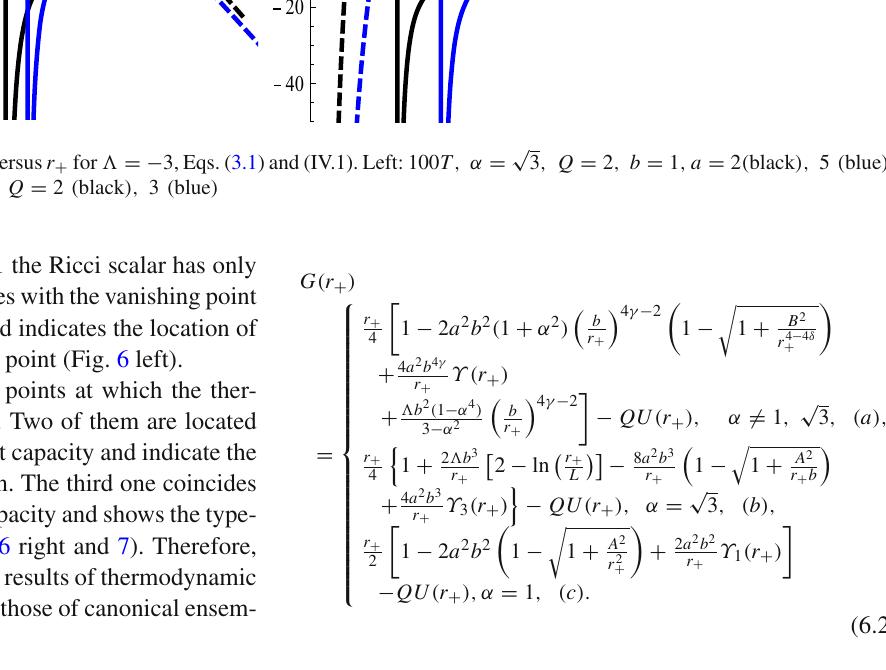
Fig. 5 T ( dashed ) and C Q ( continues ) versus r + for (cid:11) = − 3, Eqs. (3.1) and (IV.1). Left: 100 T , α = Right: 200 T , α = 1 , a = 2 , b = 0 . 75 , Q = 2 ( black ), 3 ( blue )